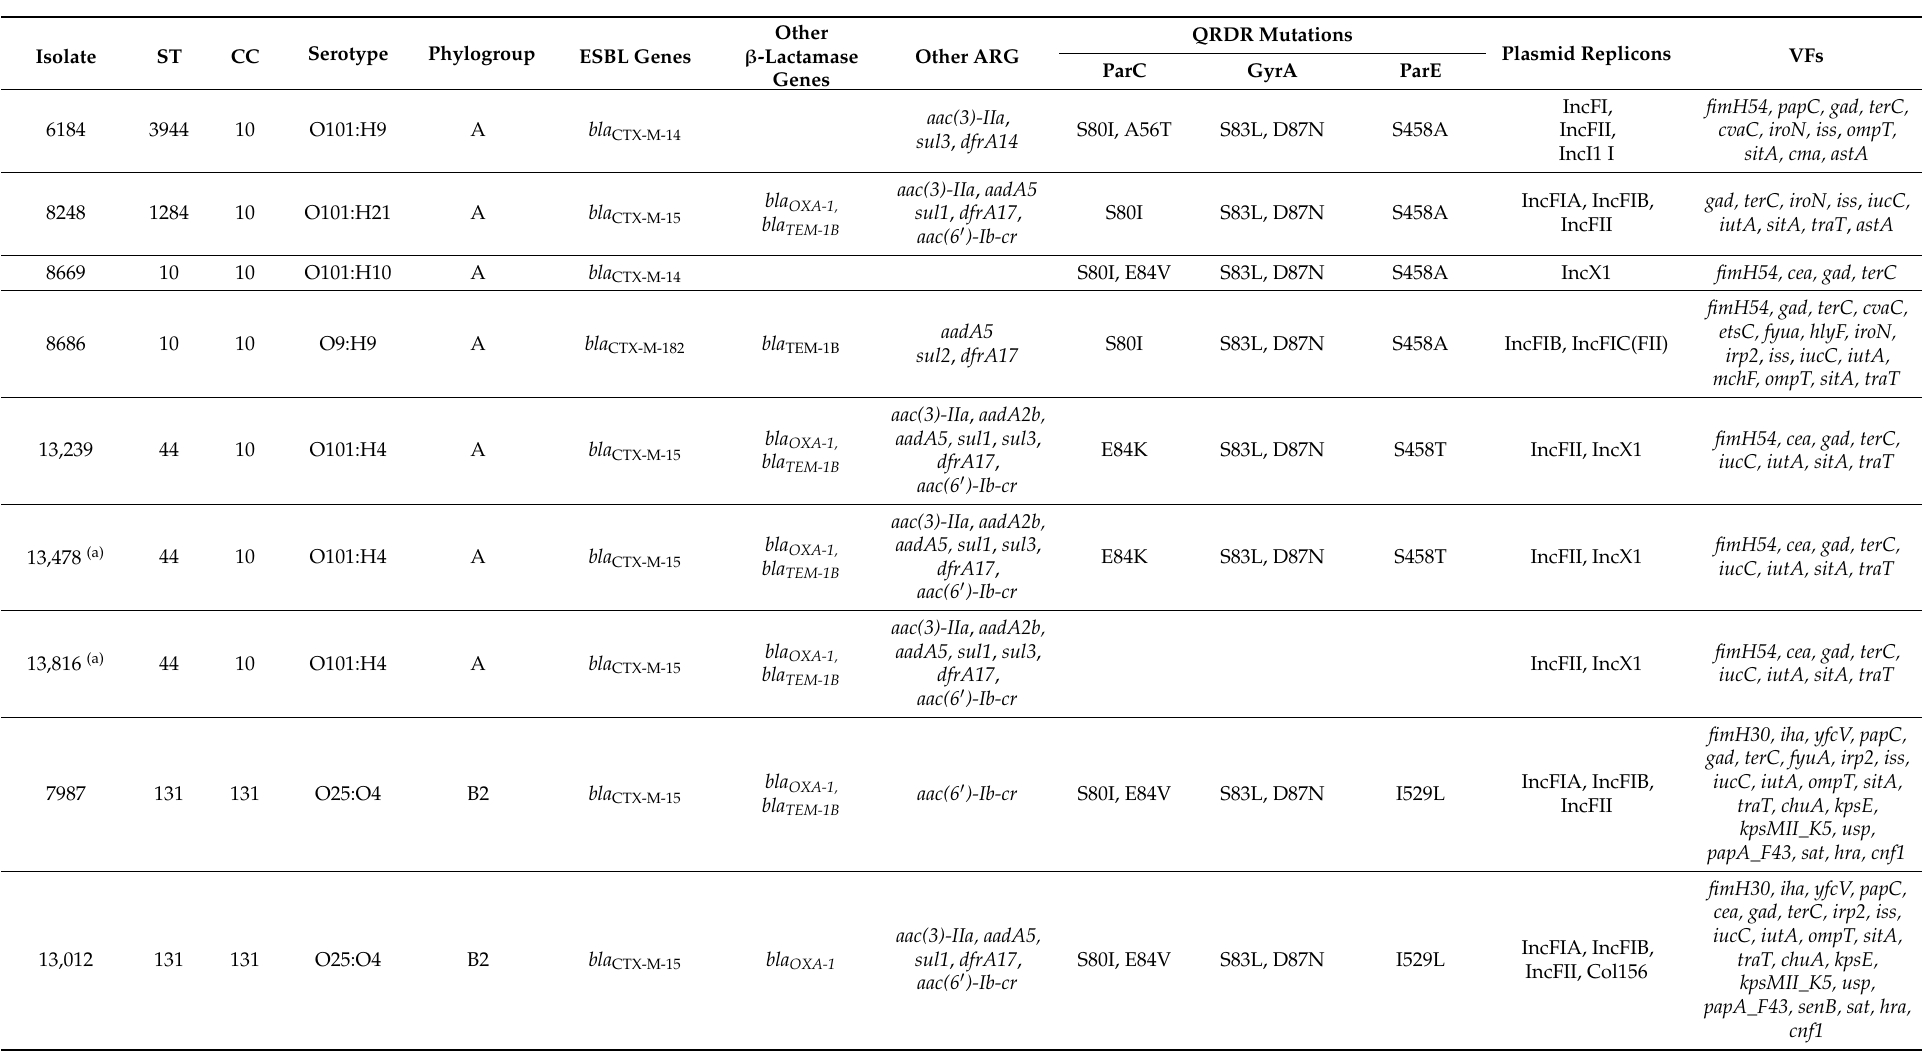
Table 1. Description of the predominant sequence types (ST) and clonal complexes